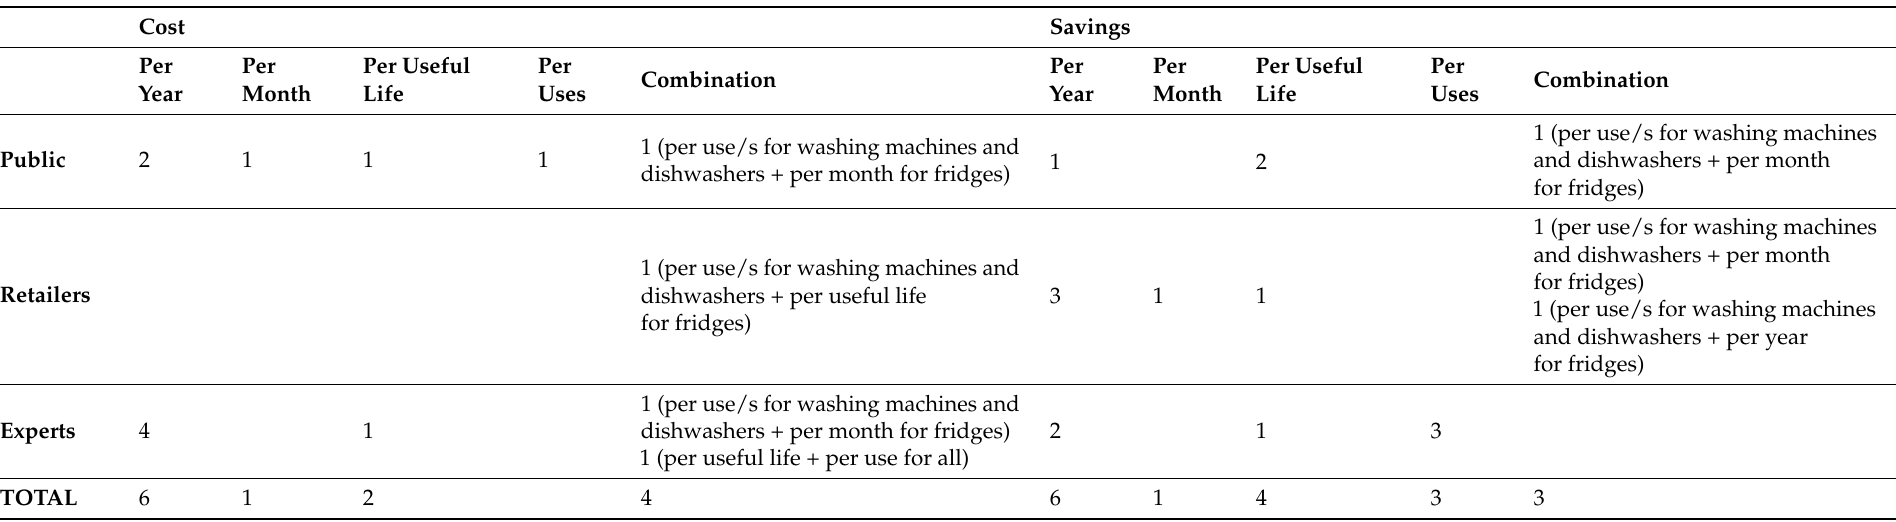
Table A5. Units for measuring energy cost and energy savings mentioned by participants in all three types of interviews (public, retailers and